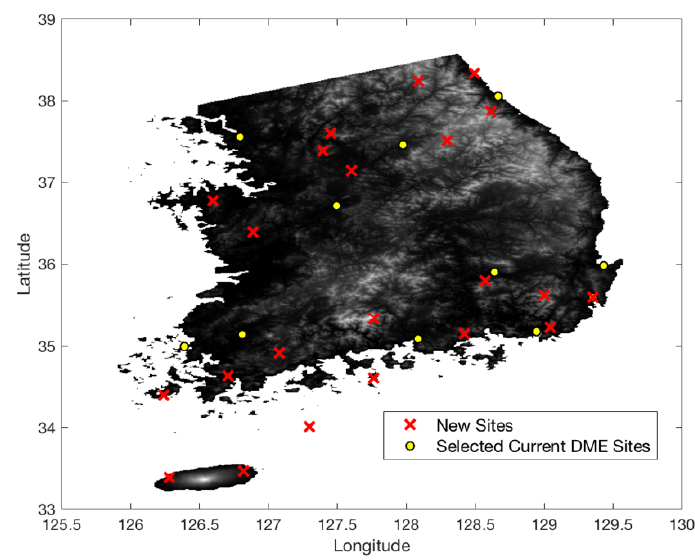
Figure 18. Augmented DME network for RNAV 0.3 nm with DME/S (five-channel scanning DME) in South Korea.